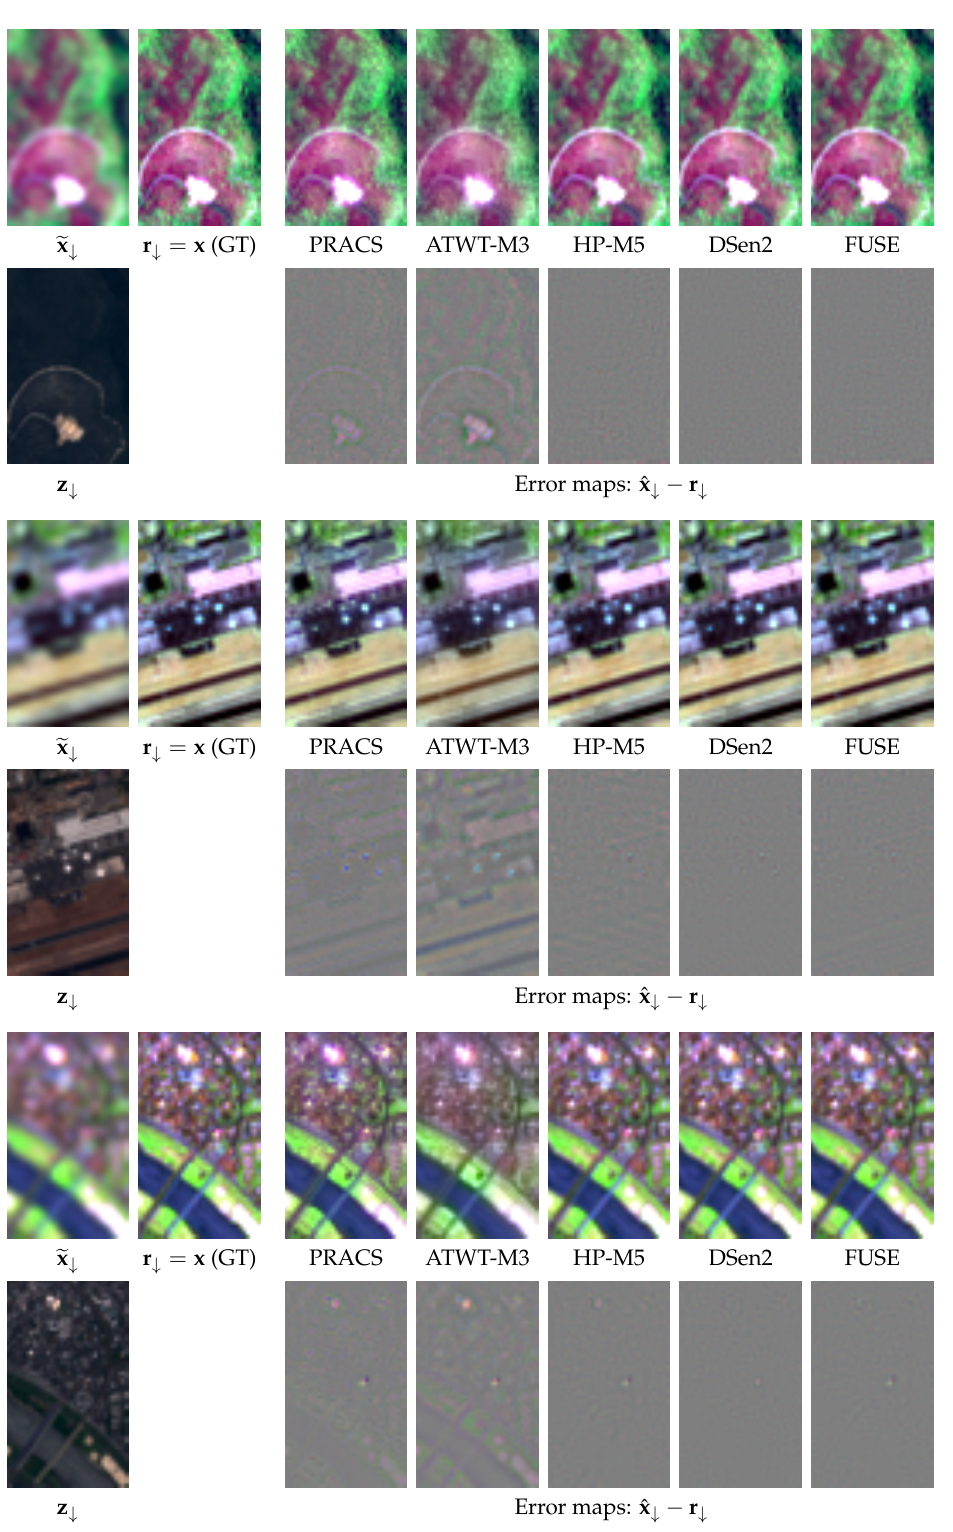
Figure 7. Reduced-resolution samples. Bottom images (Columns 3–7) show the difference with the ground-truth